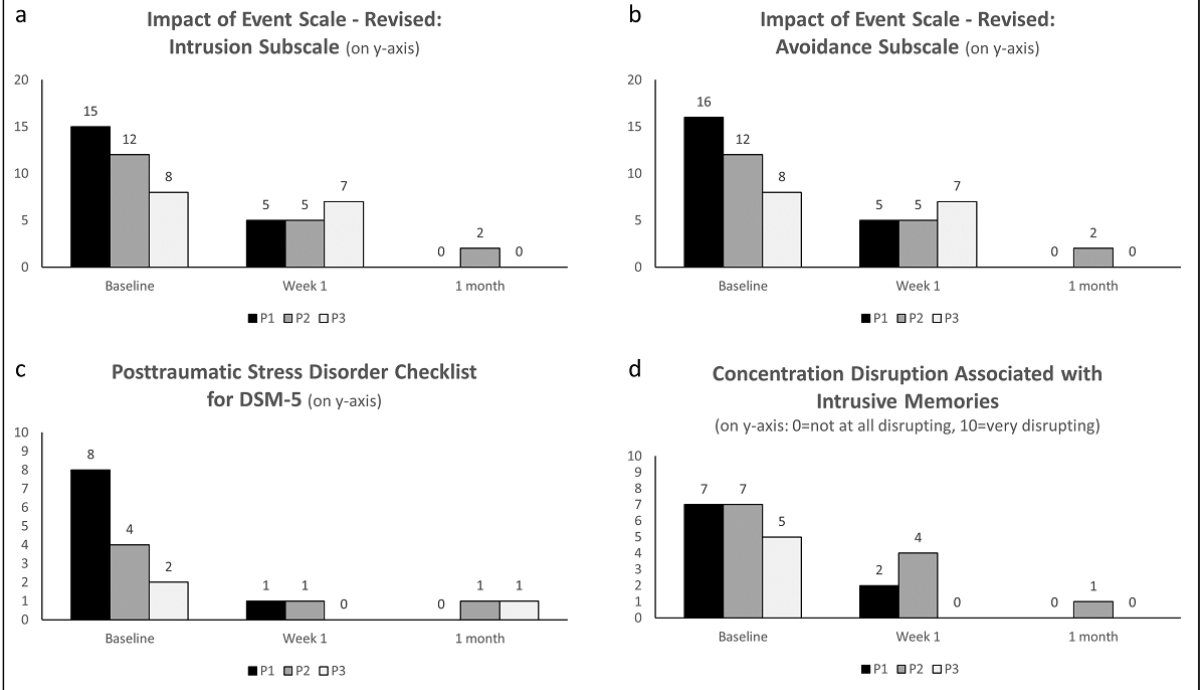
Figure 3. Bar graphs showing examples of intrusion-related symptoms (posttraumatic stress) and participant’s perception of their functioning in terms of concentration disruption (all secondary and other outcomes). All 3 participants reported reductions in intrusion (a) and avoidance (b) symptoms on the Impact of Event Scale-Revised from baseline to week 1 and the 1-month follow-up. Participant’s total scores on the Posttraumatic Stress Disorder Checklist for DSM-5 (c) decreased from baseline to week 1 and the 1-month follow-up. All 3 participants reported that their perceived concentration disruption associated with having an intrusive memory (d) decreased from baseline to week 1 and the 1-month follow-up. DSM-5: Diagnostic and Statistical Manual of Mental Disorders (5th